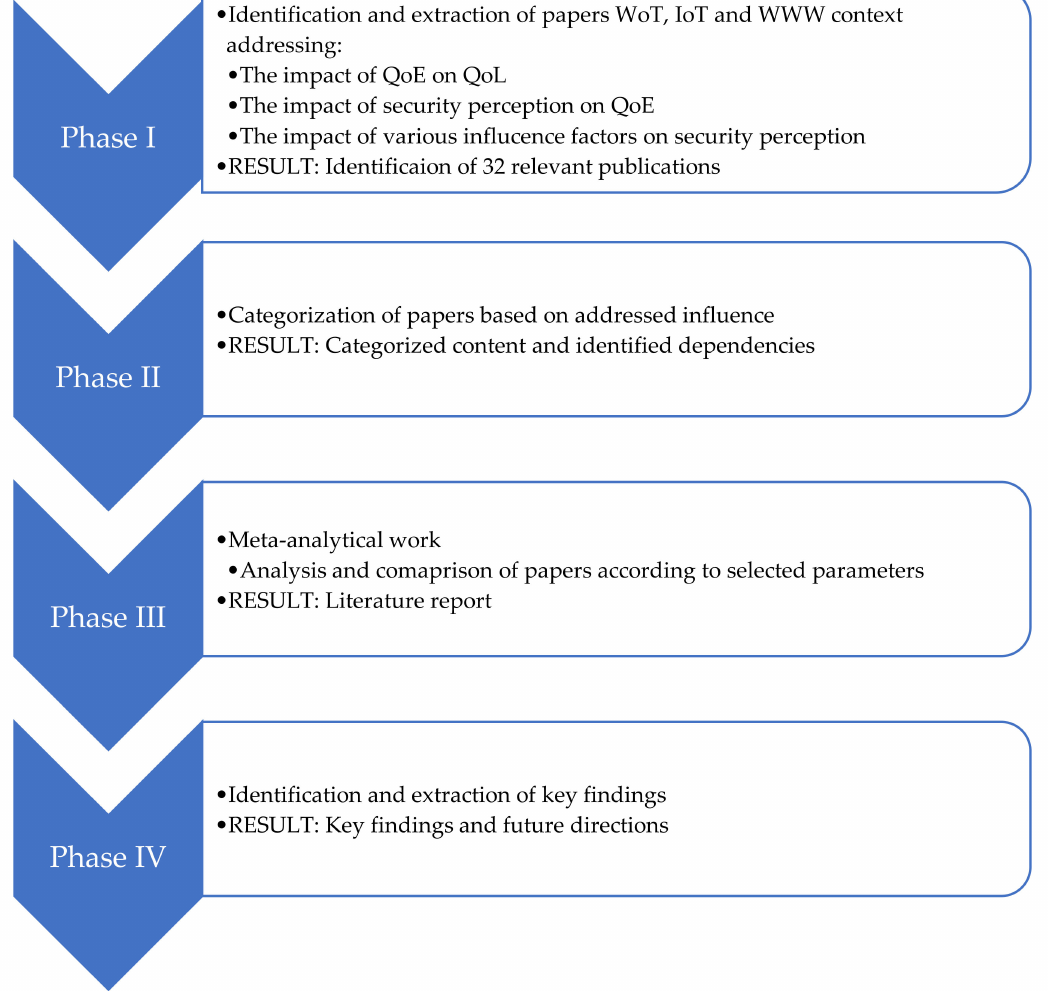
Figure 2. Phases of research